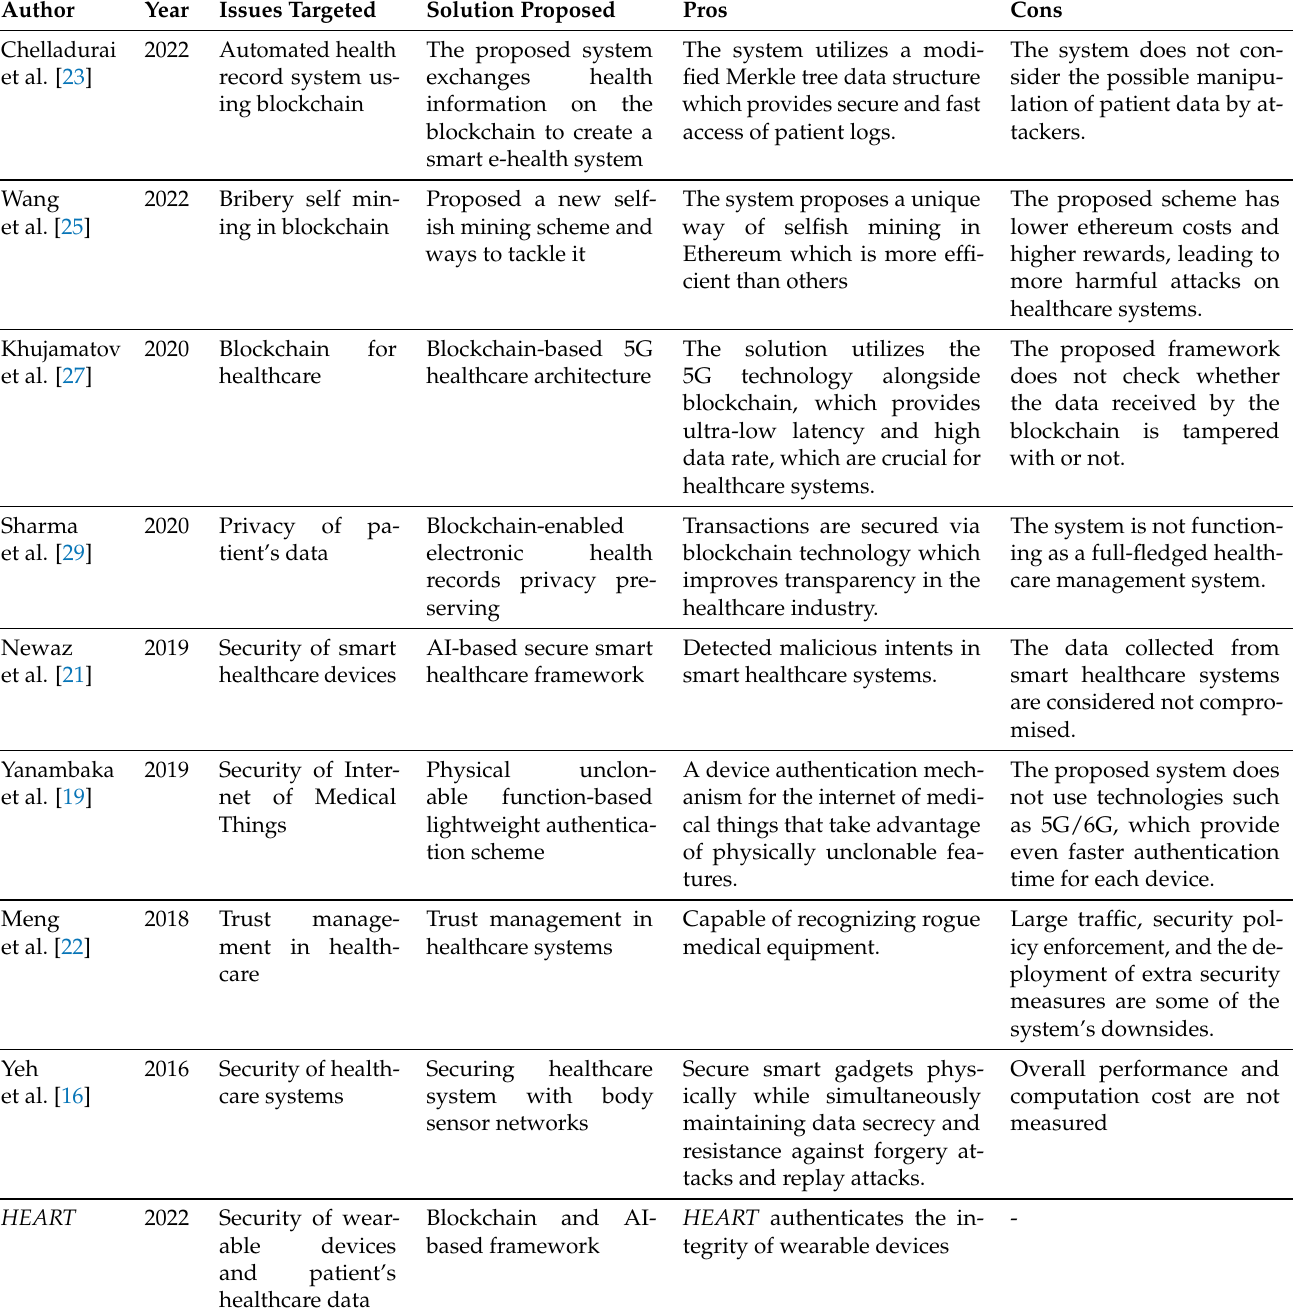
Table 1. A comparative table between the existing state-of-the-art works and the proposed